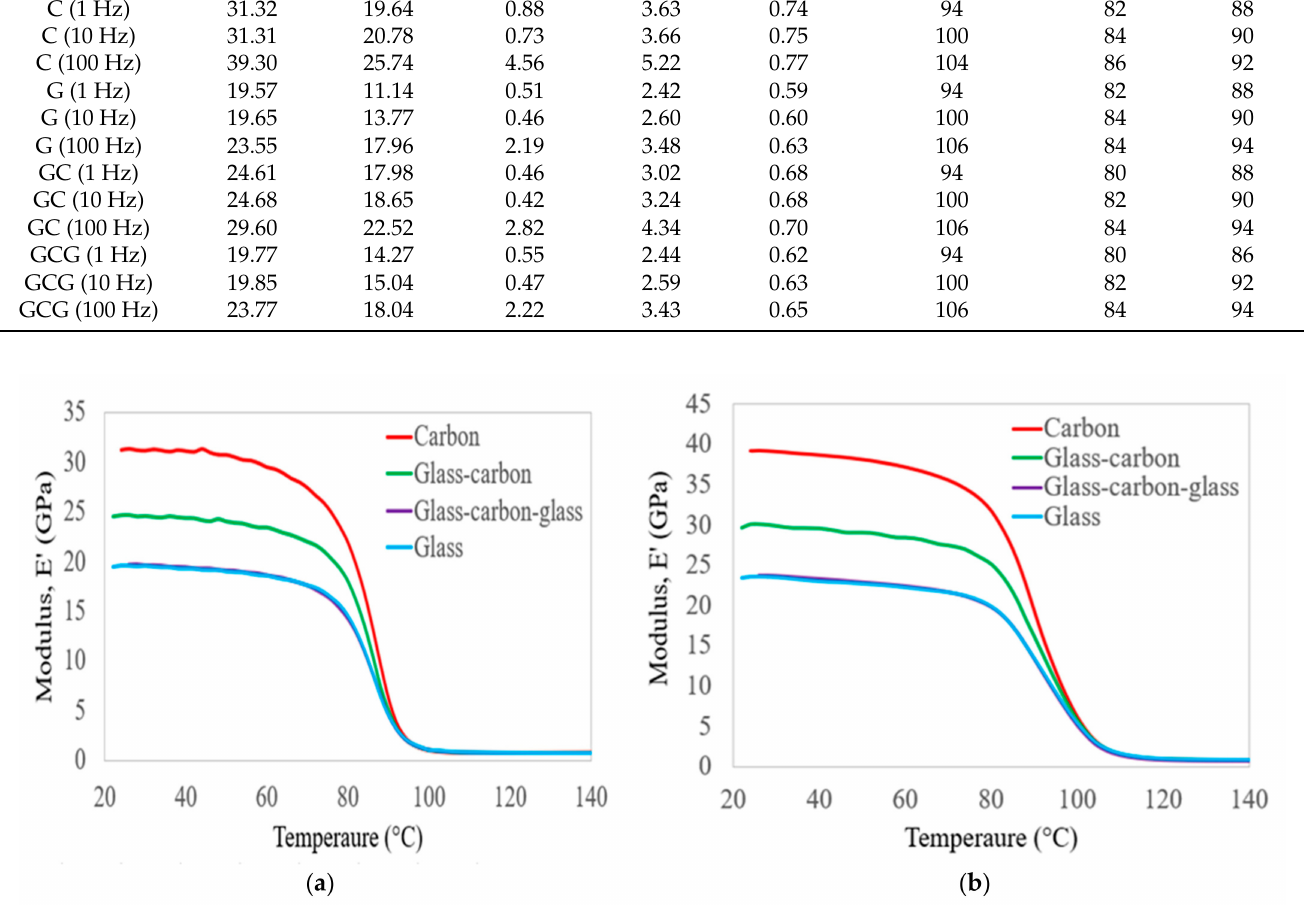
Figure 5. Comparison of the values of storage modulus on hybrid and non-hybrid bidirectional laminates at frequencies of ( a ) 1 Hz and ( b ) 100